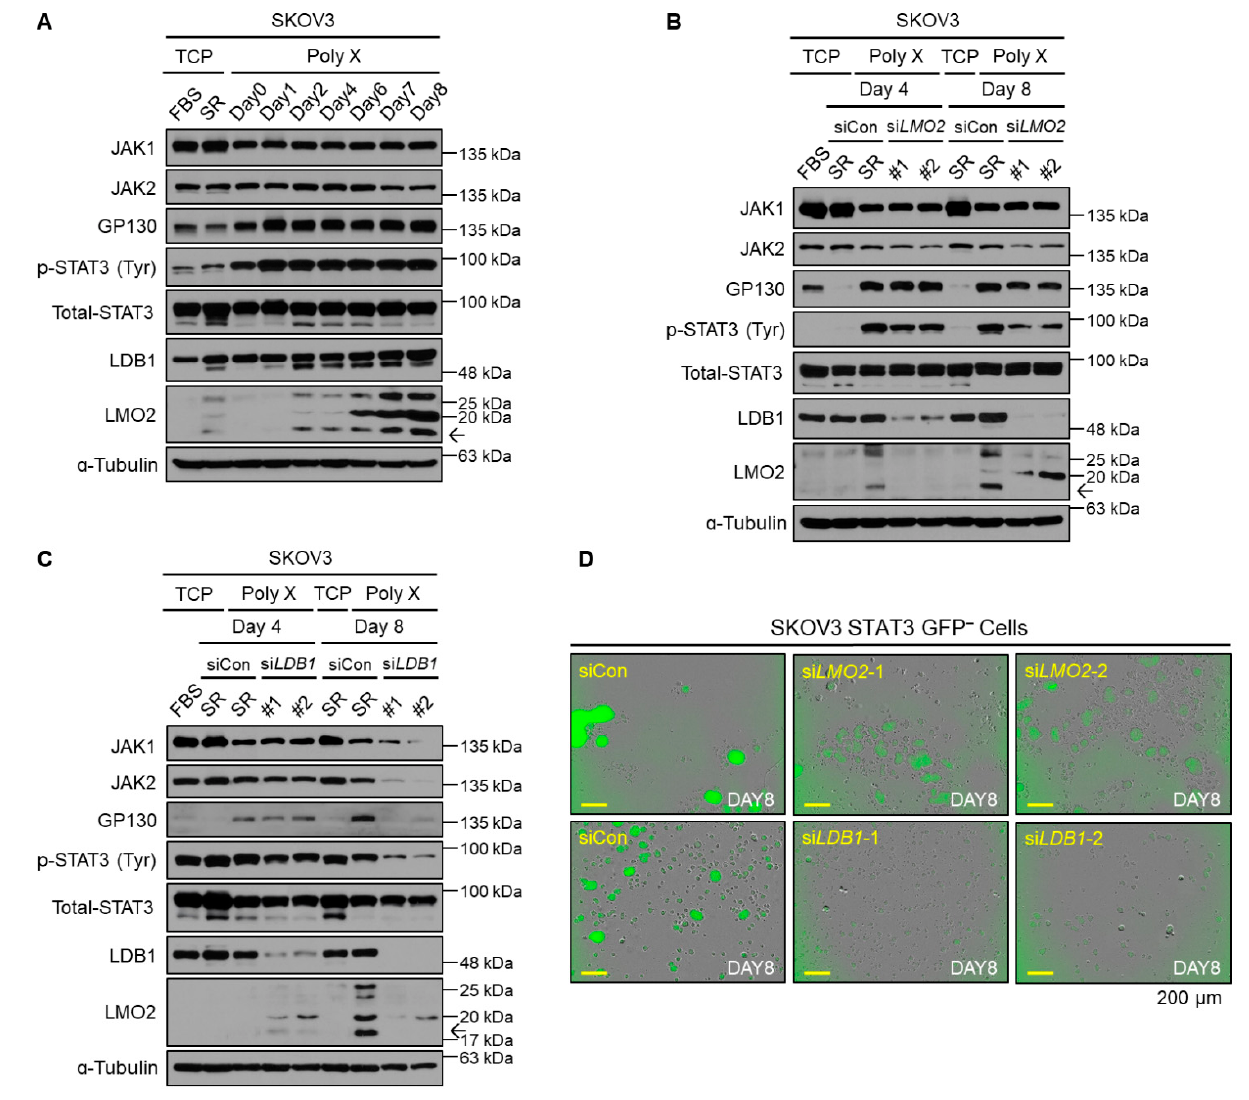
Figure 3. Long-term activation of STAT3 signaling via LMO2-LDB1 complex. ( A ) Cell lysates from SKOV3 cancer cells cultured on polymer X by date were immunoblotted with antibodies specific to JAK1, JAK2, GP130, p-STAT3, total STAT3, LMO2, LDB1, and α -tubulin. ( B ) Cell lysates from SKOV3 cancer cells transfected with either non-target siRNA or si LMO2 , cultured on TCP or polymer X on days 4 and 8, were immunoblotted with antibodies specific to JAK1, JAK2, GP130, p-STAT3, total STAT3, LMO2, LDB1, and α -tubulin. ( C ) Cell lysates from SKOV3 cancer cells transfected with either non-target siRNA or si LDB1 , cultured on TCP or polymer X on days 4 and 8, were immunoblotted with antibodies specific to JAK1, JAK2, GP130, p-STAT3, total STAT3, LMO2, LDB1,